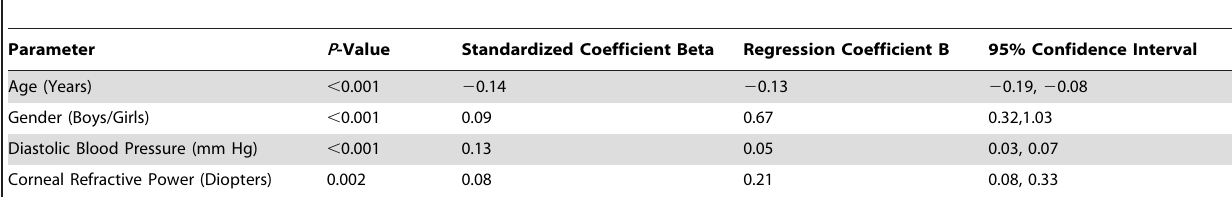
Table 4. Associations (Multivariate Analysis) between Intraocular Pressure (Left Eyes) and Systemic and Ocular Parameters in the Gobi Desert Children Eye